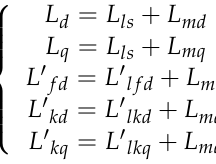
( b ) Figure 5. Linear model diagram of the exciter and rotating rectifier: ( a ) block diagram of the average model; ( b ) system space vector diagram. Based on the average model, the equation of the rotating rectifier was given by: (